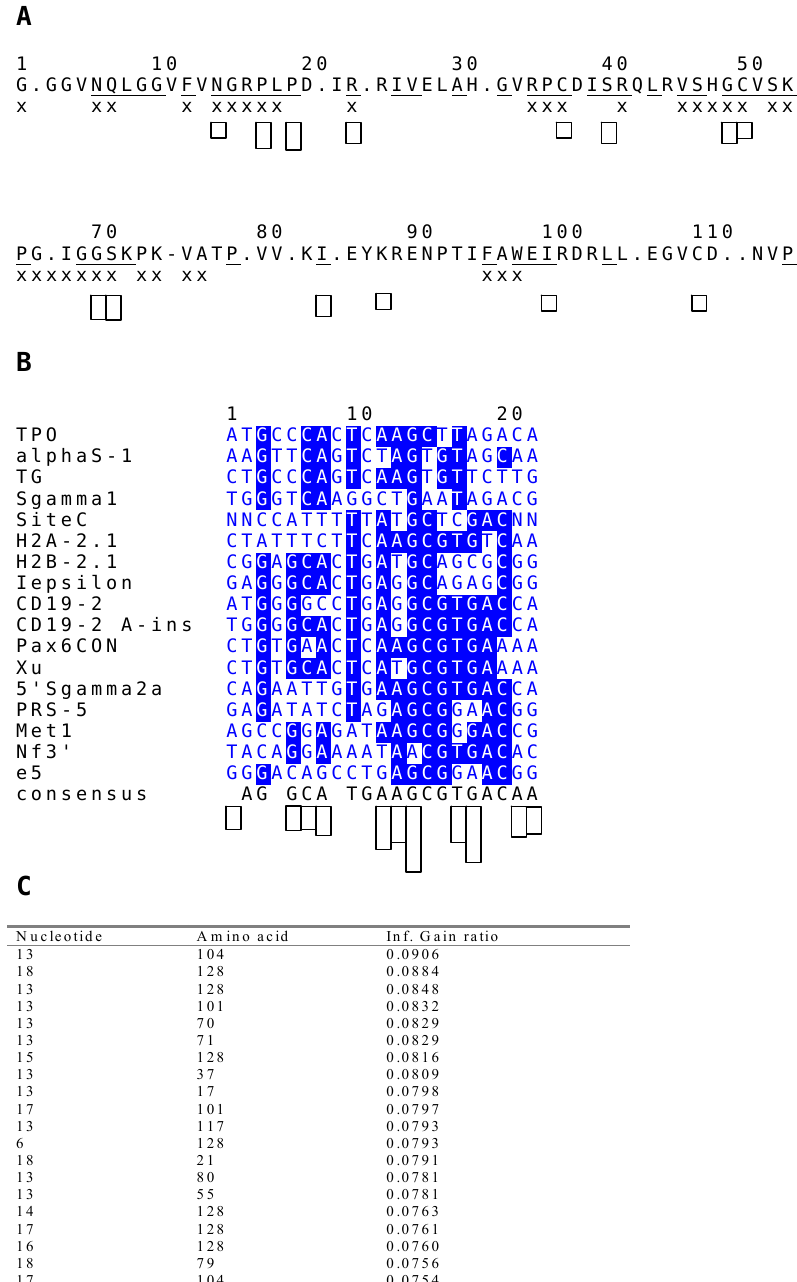
Figure 1. Paired domain information gain profiles. In a) a consensus paired domain with the conserved residues (invariant in most wildtype proteins [60]) shown underlined. Sites that vary too much to reach a meaningful consensus are shown with a period (‘.’). DNA contact points of Pax6 and Paired [16, 17] are shown under the sequence with ‘x’. Between position 74 and 75 (where Pax3 and Pax7 have an additional residue) a gap in the alignment is shown with a hyphen (‘-‘). The information gain ratios for the 15 most informative sites are shown as histobars directly under the consensus sequence. The height of the bar is proportional to the information gain ratio of the corresponding site. Note that many of the positions with high information peaks are located close to residues that make DNA contacts. Panel b) shows a nucleotide alignment of a subset of the DNA sites analyzed, together with the information gain profile for the ten most informative nucleotide sites under the alignment. The sites are named as in their primary reference. The N-terminal end binds to site 10-21, the C-terminal to 1-7, and the linker to 8-15. In c) the top 20 combinations of sites are shown in the order of the information they provide. Column 1 shows nucleotide positions numbered 1-21 as in the alignment in panel b); column 2 shows the amino acid residues numbered 1-128 as in panel a) above; and 3) finally shows the information that doublet